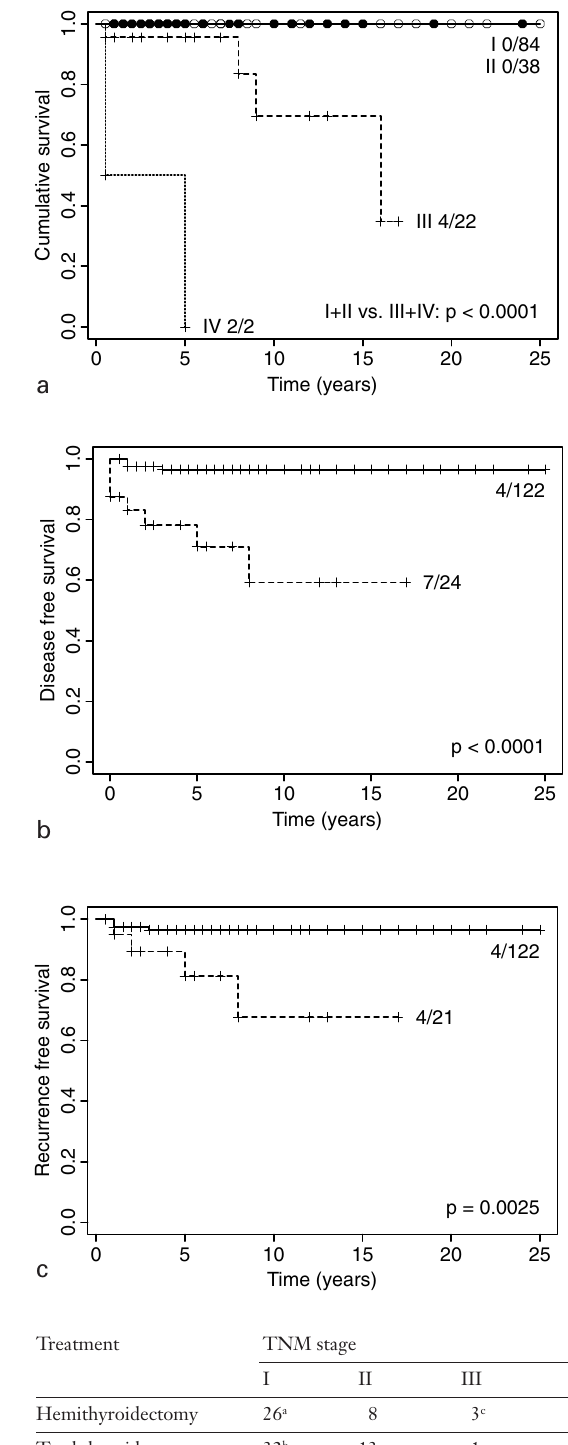
Papillary thyroid carcinoma (n = 146). Primary treatment and outcome, by risk groups. (No of patients [%])